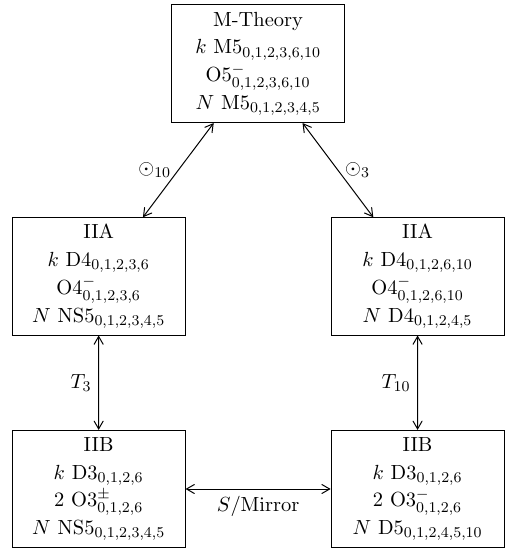
Figure 4 . Summary of the dualities for deconstruction of type D . Directions 3, 6 and 10 are compact S 1 , while the other directions are